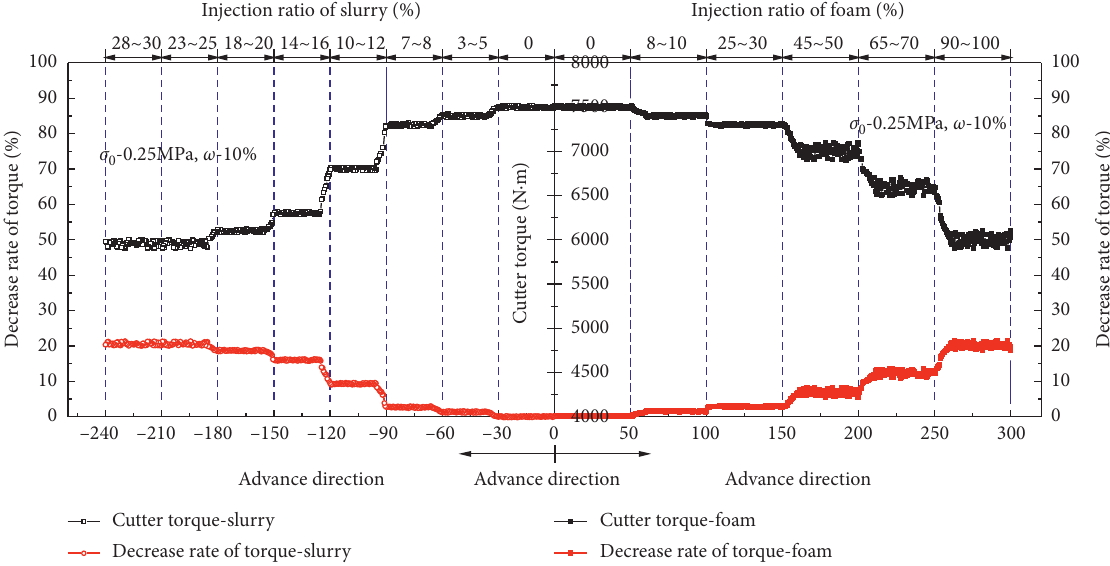
Figure 29: Effect of two types of soil conditioners on cutter torque at water content 10% and soil pressure